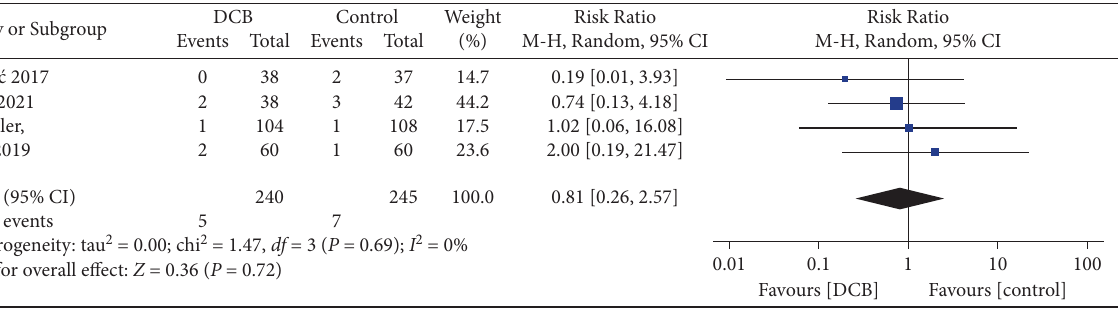
Figure 2: Summary plots for the clinical endpoint. Risk ratios of major adverse cardiac events (a), myocardial infarction (b), all-cause death (e), cardiovascular mortality (f), stent thrombosis (g), and target lesion revascularization (h); subgroup analysis for major adverse cardiac events (c) and myocardial infarction (d) according to indication. Te relative size of the data markers indicates weight of sample size from each study. DCB: drug-coated balloon; DES: drug-eluting stent; BMS: bare-metal stent. Weight DCB Control Mean Difference Mean Difference Study or Subgroup Mean SD Total Mean SD Total (%) IV, Random, 95% CI IV, Random, 95% CI